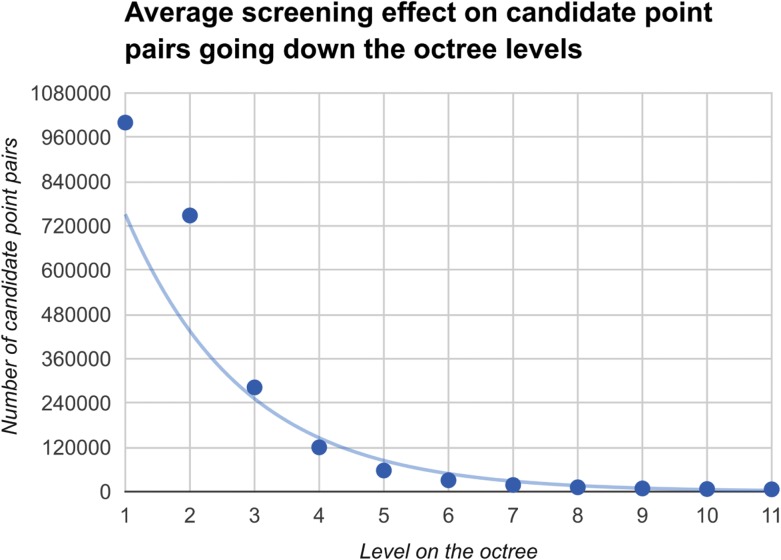
Averaging over 60 runs on different octree pairs, we show the number of candidate point pairs goes down at least exponentially as we select only those pairs of cubes that pass the Necessary Condition 1. The best exponential fit to the data is shown.